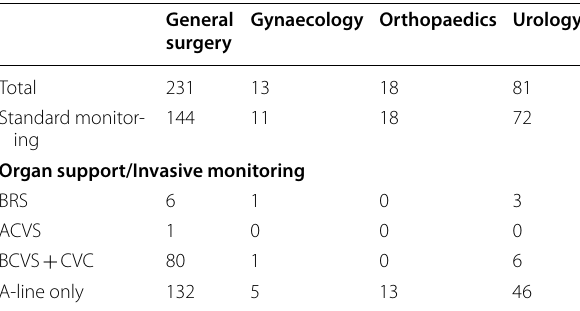
Table 2: Discharges from HDU to wards